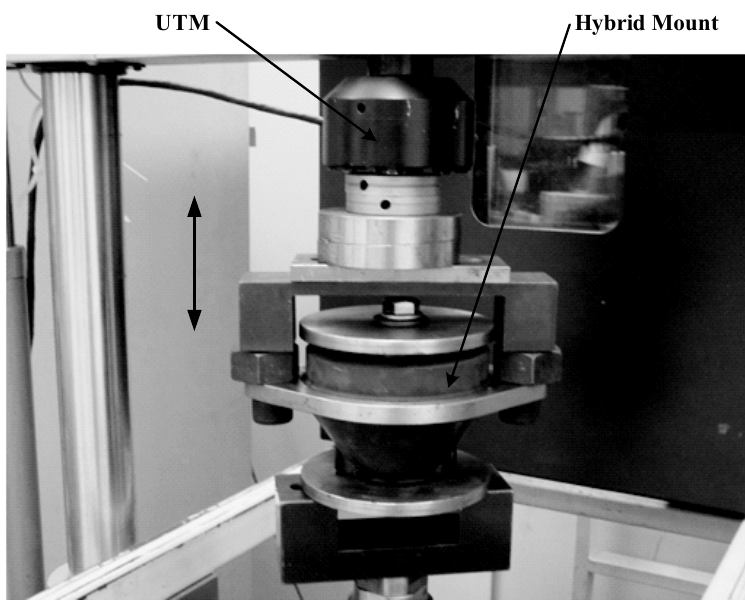
Fig. 14. Photograph of fatigue